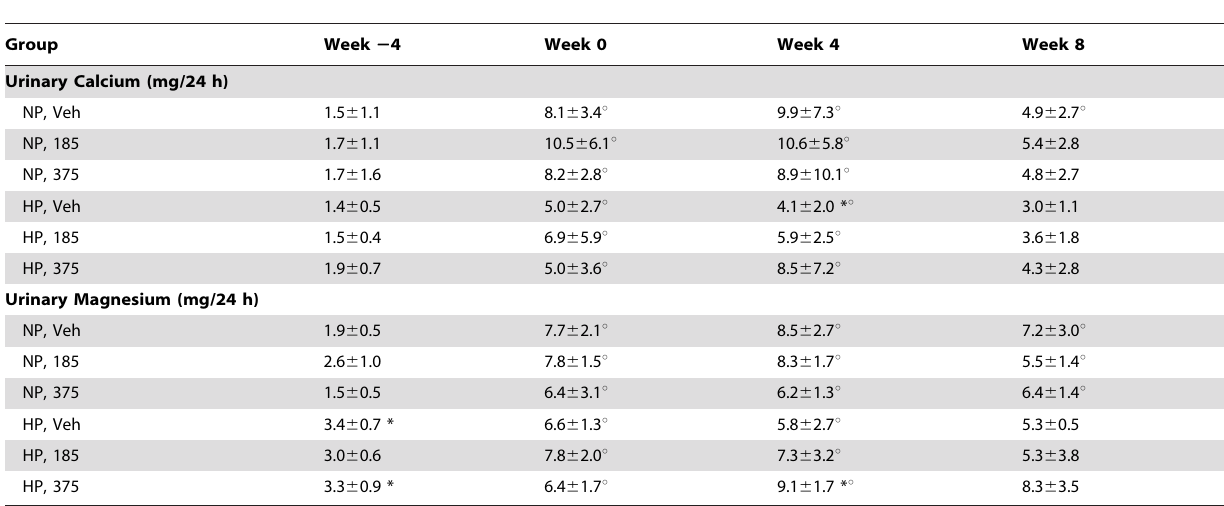
Table 3. Urine biochemistry over time of 5/6 th nephrectomized rats receiving normal phosphorus (NP) or high phosphorus (HP) diet, in combination with vehicle (Veh), 185 or 375 mg/kg CaMg.